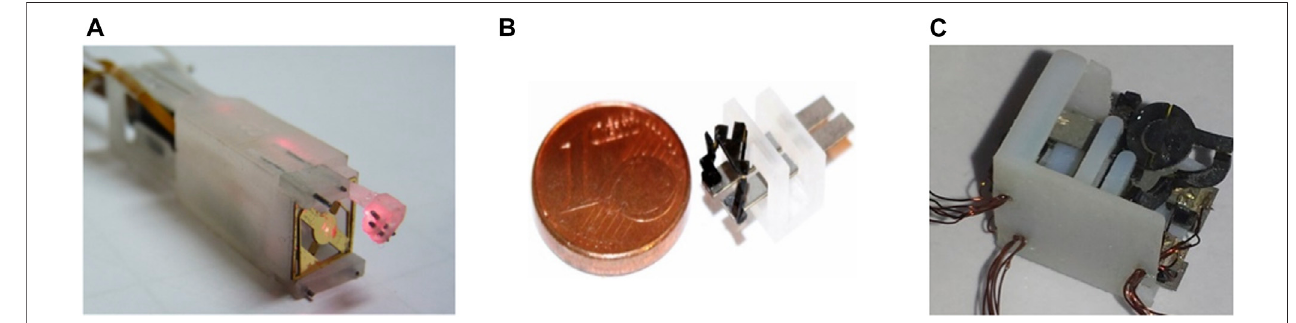
FIGURE 3 | Micro-robotic laser micromanipulators developed during µRALP. (A) Squipabot (Rabenorosoa et al., 2014). (B) PIBOT (Lescano, 2015). (C) Micro Agile-Eye (Lescano, 2015).